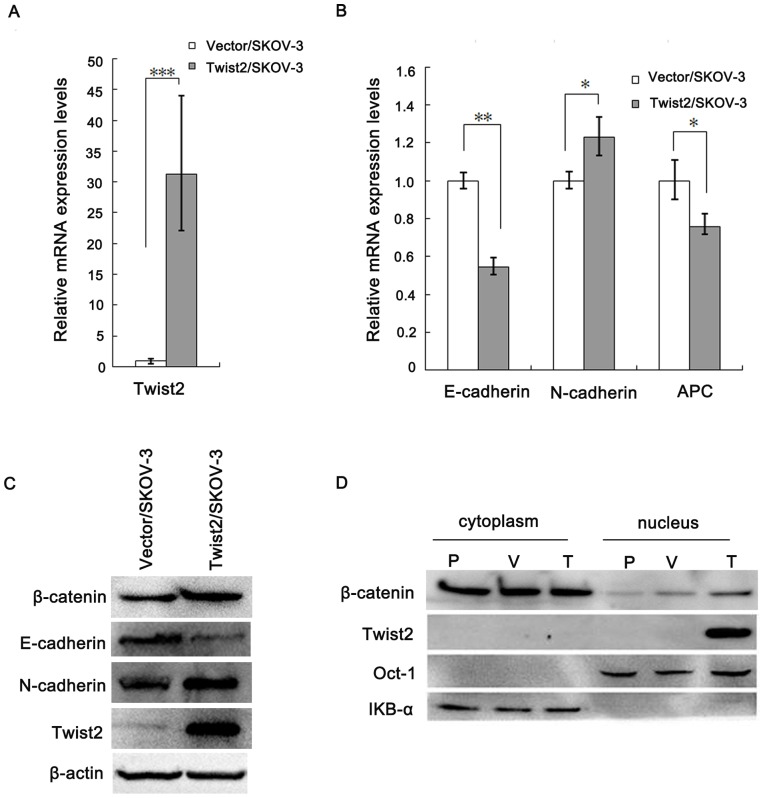
Twist2 changed the expressions of E-cadherin, N-cadherin, and distribution of β-catenin in SKOV-3 cells.
A and B. Real time PCR results of Twist2, E-cadherin, N-cadherin, and APC mRNA expressing levels in the Twist2-expressing cells and the vector-transfected control cells (*P<0.05,**P<0.01,***P<0.001). C. Western Blot results of Twist2, E-cadherin, N-cadherin, β-catenin expression in the Twist2/SKOV-3 cells compared with the Vector/SKOV-3 control cells. D. Distribution of β-catenin in cytoplasm and nucleus detected by the cell fractionation method. P-parental SKOV-3 cancer cells, V-vector-transfected control cells, T-Twist2-expressing SKOV-3 cells.